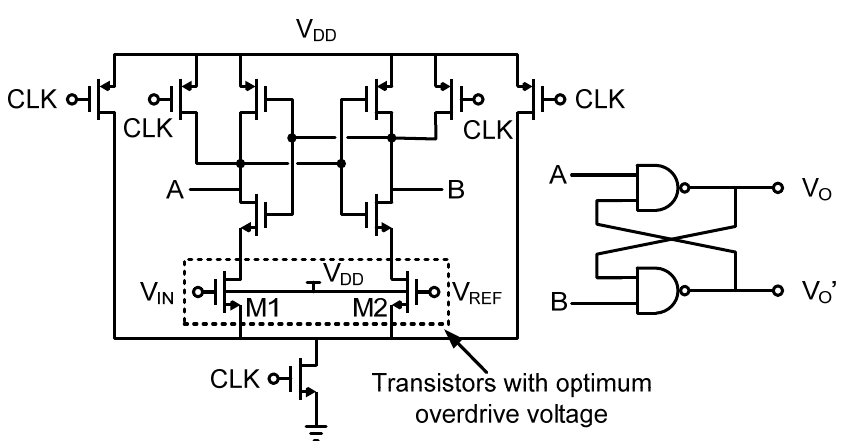
Figure 4. Schematic of the comparator using the optimum overdrive voltage technique.